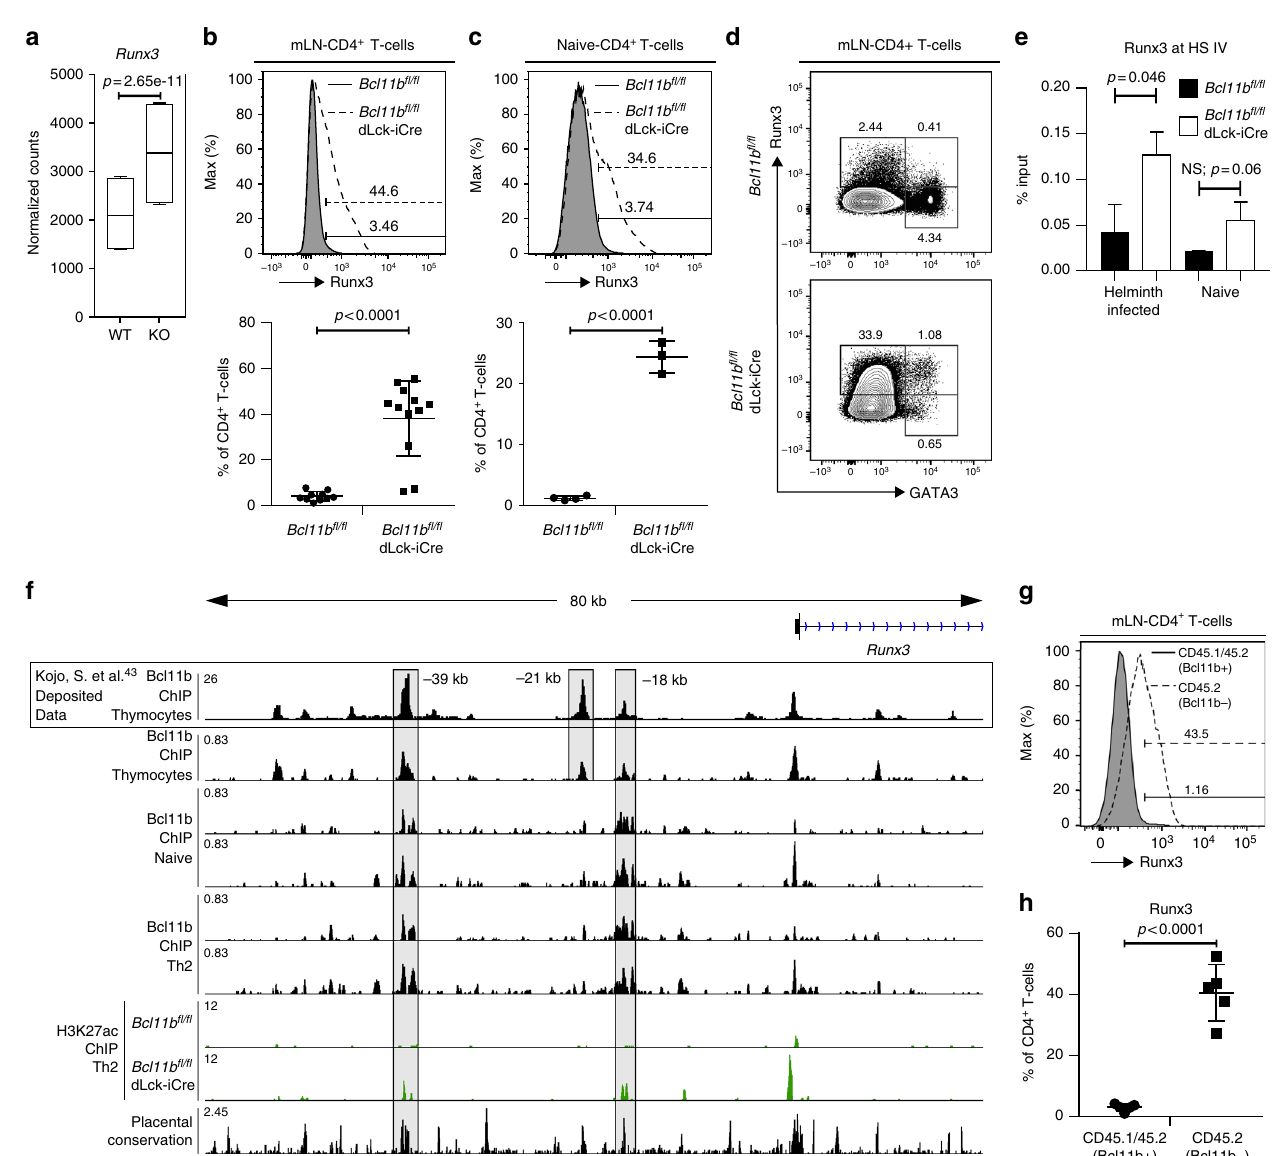
Fig. 7 Bcl11b binds to enhancers upstream of Runx3 locus to restrain Runx3 expression in CD4 + T-cells. a Box and whisker plots of normalized counts for Runx3 from RNA-Seq on CD4 + T-cells from the mesenteric (m)LNs of helminth-infected mice. Data ( n = 4) are derived from two independent experiments. p values have been adjusted for the FDR (false discovery rate) by the Benjamini – Hochberg adjustment. b Flow cytometry analysis of Runx3 in CD4 + T-cells from the mLNs of H. polygyrus bakeri infected Bcl11b fl / fl ( n = 10) and Bcl11b fl / fl dLck-iCre ( n = 12) mice (top) and their relative frequencies (bottom). Data shown are from fi ve independent experiments. c Flow cytometry analysis of Runx3 in CD4 + T-cells from the mLNs of naive Bcl11b fl / fl ( n = 4) and Bcl11b fl / fl dLck-iCre ( n = 3) mice (top) and their relative frequencies (bottom). Data shown are from two independent experiments. d Flow cytometry analysis of Runx3 vs. Gata3 in total CD4 + T-cells from the mLNs of helminth-infected mice. Data representative of three independent experiments. e Runx3 enrichment at the HS IV silencer determined by Runx3 ChIP-qPCR performed on CD4 + T-cells isolated from the mLNs of helminth- infected mice or the spleen and peripheral lymph nodes of naive mice. ChIP-PCR enrichment is expressed as a percentage of input ( n = 2). f Integrative Genomics Viewer visualizations of Bcl11b ChIP-Seq in total thymocytes (deposited data from Kojo et al. 43 ) (top track), Bcl11b ChIP-Seq in CD8-enriched thymocytes from naive mice (second track), Bcl11b ChIP-Seq in naive in CD4 + T-cells (tracks 3 – 4), Bcl11b ChIP-Seq in CD4 + T-cells from H. polygyrus infected mice (tracks 5 – 6) and H3K27ac ChIP-Seq (tracks 7 – 8) in WT and Bcl11b-de fi cient CD4 + T-cells from H. polygyrus infected mice at Runx3 locus. g Histogram of Runx3 in CD4 + T-cells from the mLNs of mixed bone-marrow chimeric mice infected with H. polygyrus bakeri . Gating strategy (shown in Fig. 4g) was fi rst on CD4 + T-cells, and then on CD45.1 + CD45.2 + (WT) ( fi lled histogram) and CD45.2 + (Bcl11b − ) (dashed, open histogram). h Frequencies of Runx3 + cells in the CD4 + T-cells from the mLNs of mixed bone-marrow chimeric mice ( n = 5) infected with H. polygyrus bakeri . Data shown are from two independent experiments. All statistical values in this fi gure were calculated using Student ’ s t -test except for panel a , which was calculated using DESeq2 analysis software. All error bars shown in this fi gure are of standard